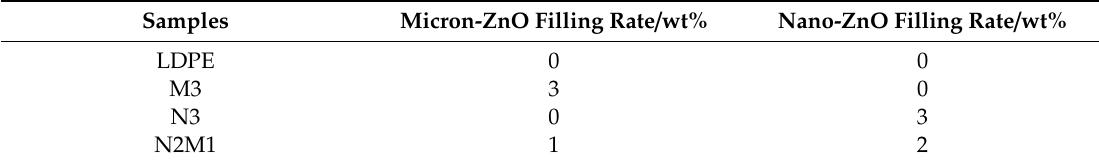
Table 1. Sample nomenclature and compositions of different ZnO/LDPE composites.